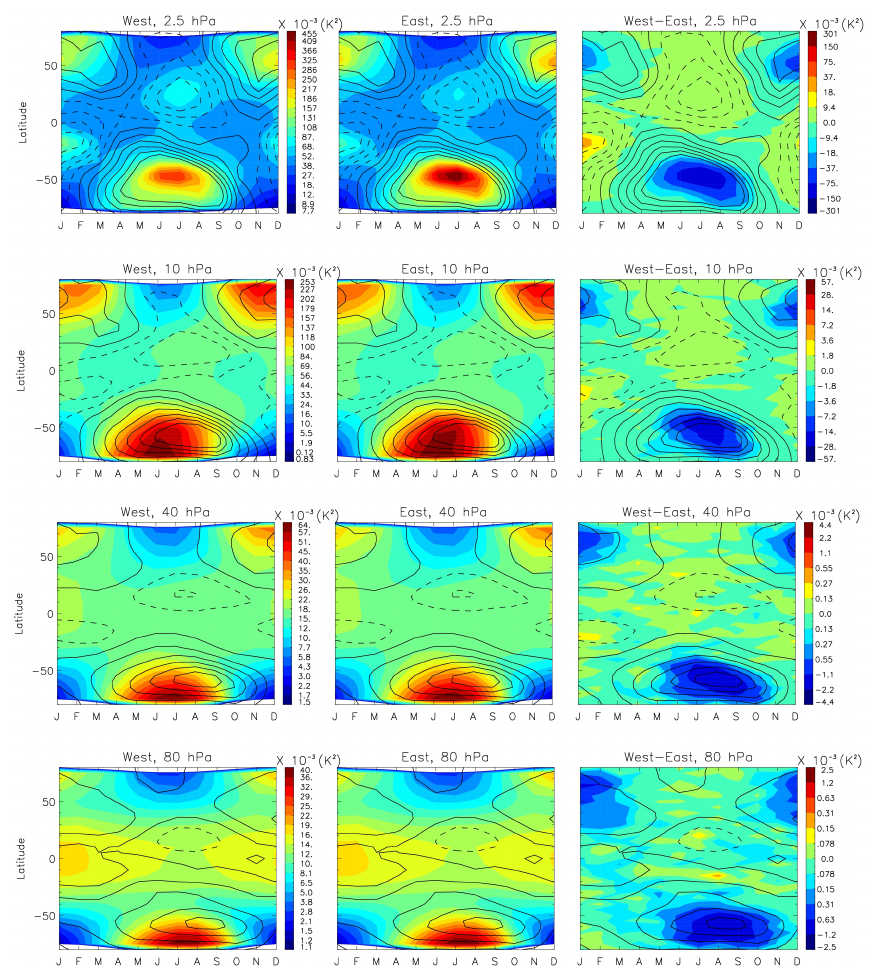
Fig. 7. Multi-year averaged timeseries of zonal mean GW variance for different months at westmost view (first column), eastmost view (second column) and their difference (third column) at 2.5, 10, 40 and 80hPa from top to bottom. The UK Met Office zonal winds are overplotted in solid (dashed) lines representing westerlies (easterlies) with contour interval of 10ms − 1 .